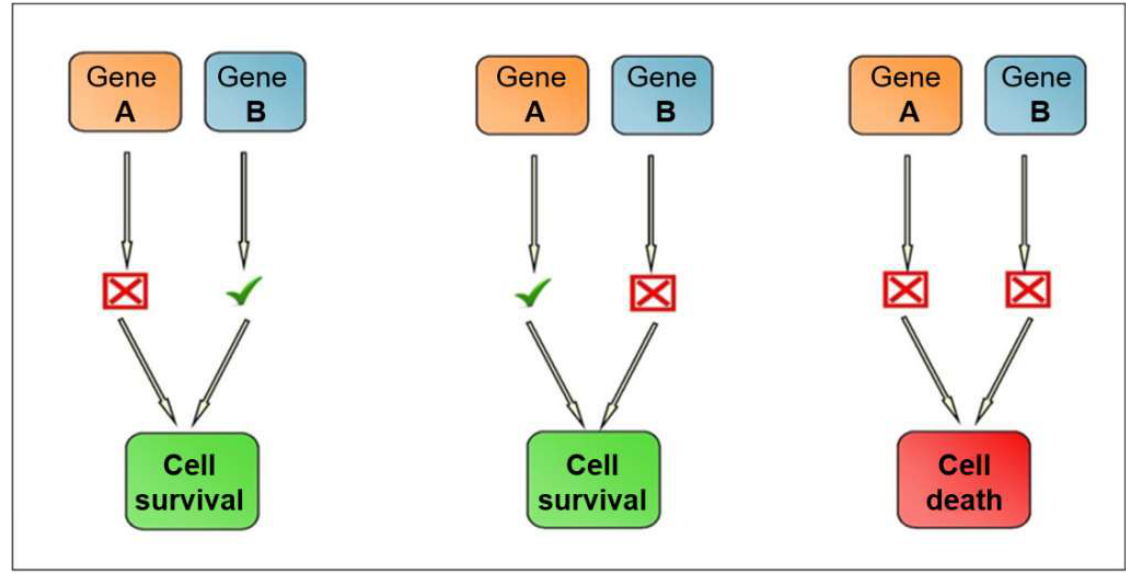
Figure 1. Schematic of synthetic lethality in cancer.